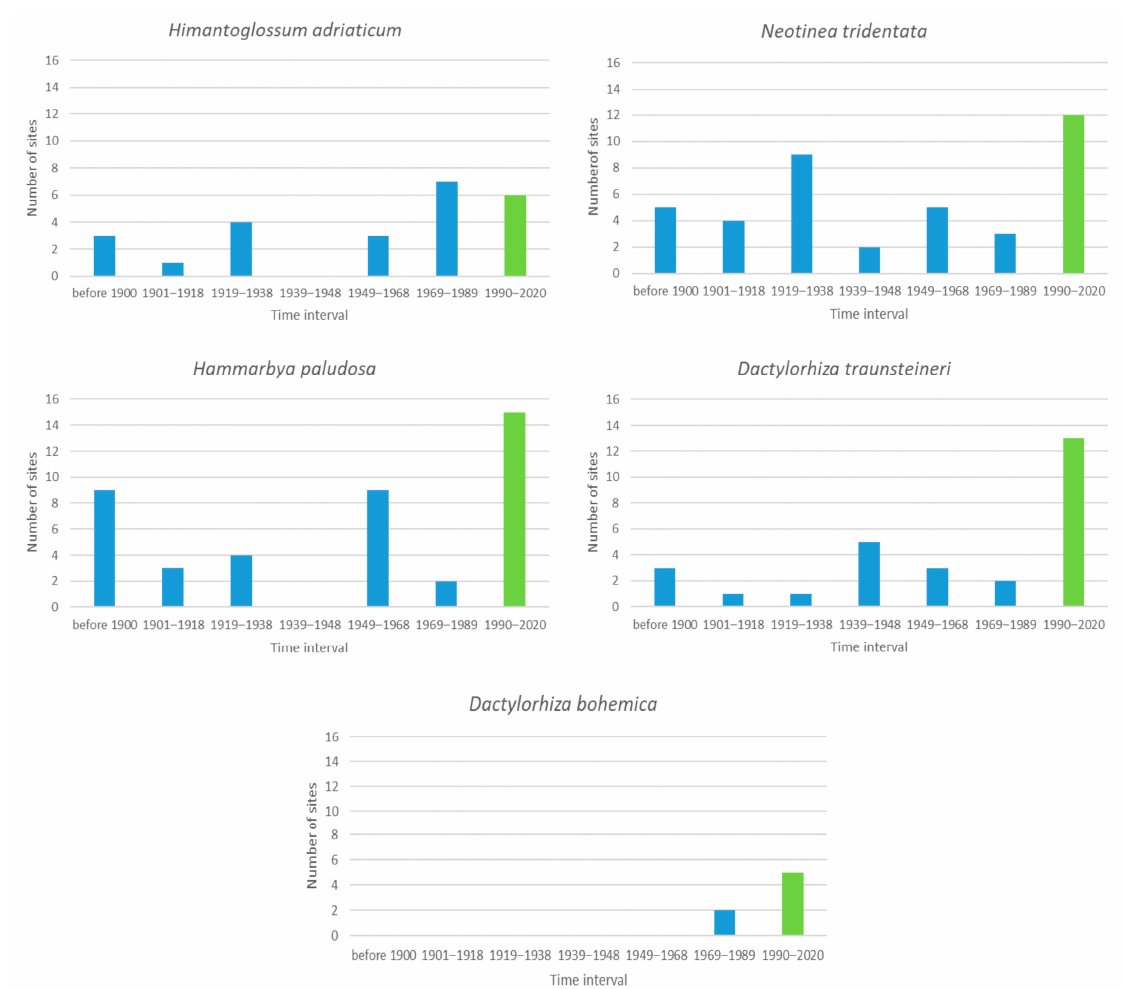
Figure 2. The blue columns are the number of sites that were occupied by orchids for the last time during the given interval and then no longer occupied for the five species that were found historically at 1 to 20 sites. The green bar indicates the number of sites observed as extant in the last interval, which we consider as extant currently.